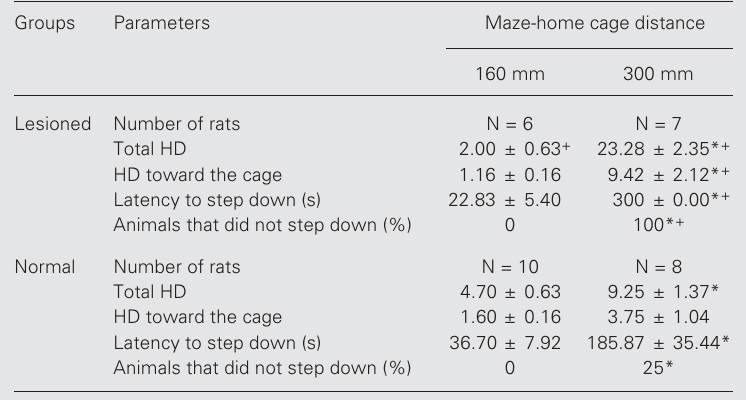
Table 1. Behavioral parameters exhibited by lesioned and normal rats to step down from the elevated maze to their home cage placed at different depths.